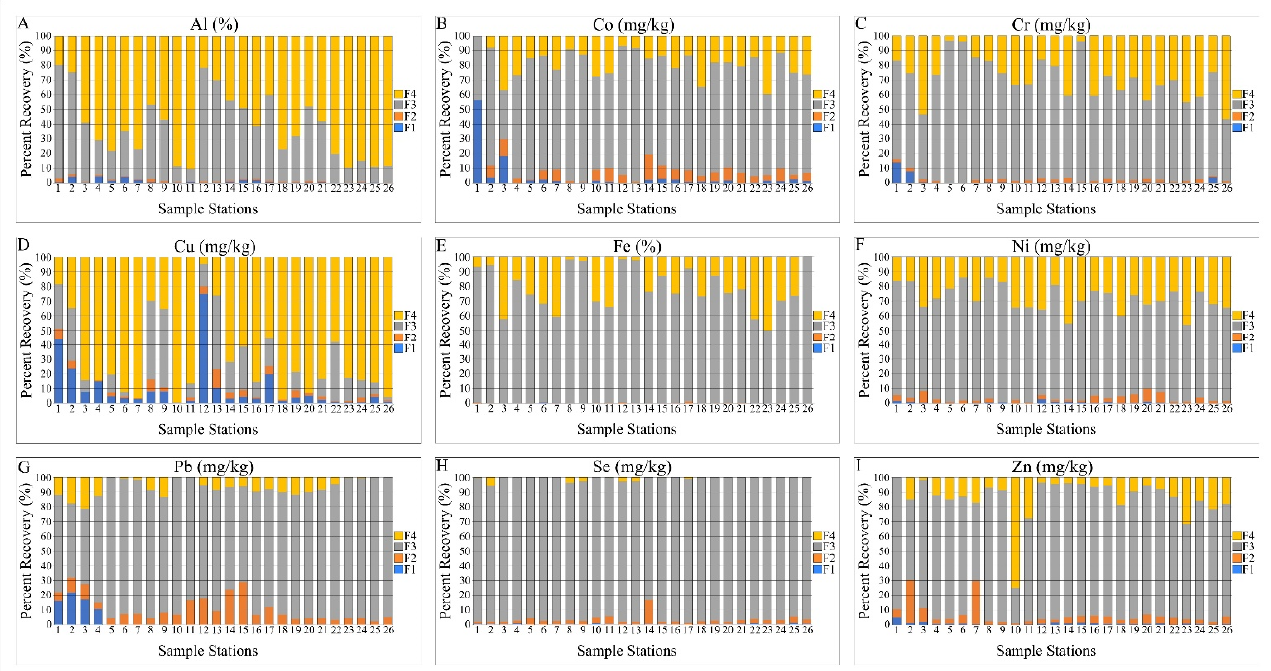
Figure 6. PTEs recovery percentage. ( A ): Aluminum (Al), ( B ): Cobalt (Co), ( C ): Chromium (Cr), ( D ): Copper (Cu), ( E ): Iron (Fe), ( F ): Nickel (Ni), ( G ): Lead (Pb), ( H ): Selenium (Se), ( I ): Zinc (Zn). All concentrations are in mg/kg except for Al, and Fe which are in (%). F1 = exchangeable; F2 = acid-soluble; F3 = reducible; and F4 = oxidizable.